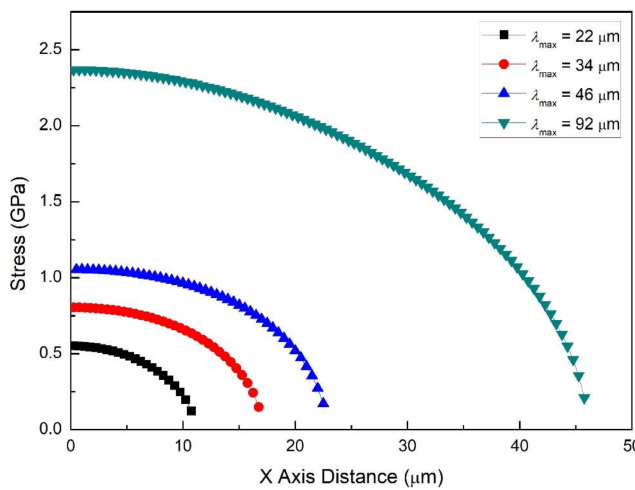
Figure 11. The TIS distribution for several crack spacing. The TIS, at any location, decreases as the crack spacing